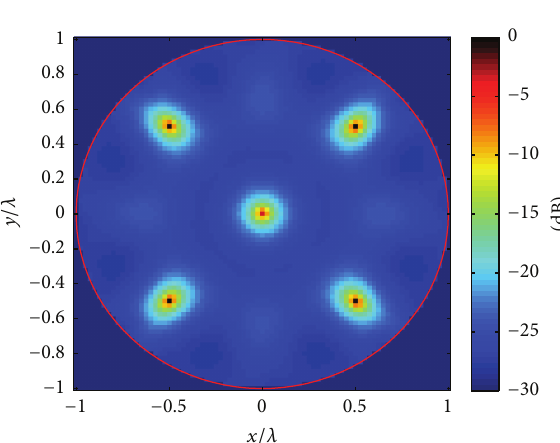
Figure 5: AIC behaviour.